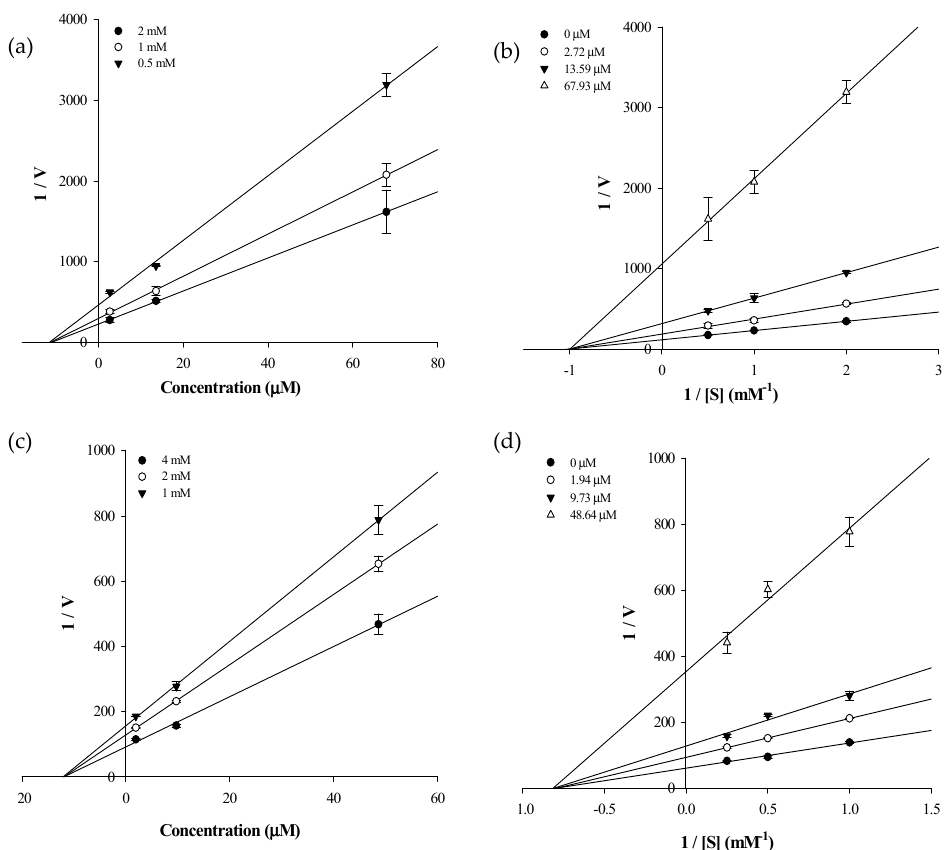
Figure 3. Dixon and Lineweaver–Burk plots of the inhibition of PTP1B by icaritin and icariside II. The results showed the effects of the presence of different concentrations of the substrate for: ( a ) icaritin; and ( c ) icariside II; and the effect of the presence of different concentration of: ( b ) icaritin; and ( d ) icariside II.